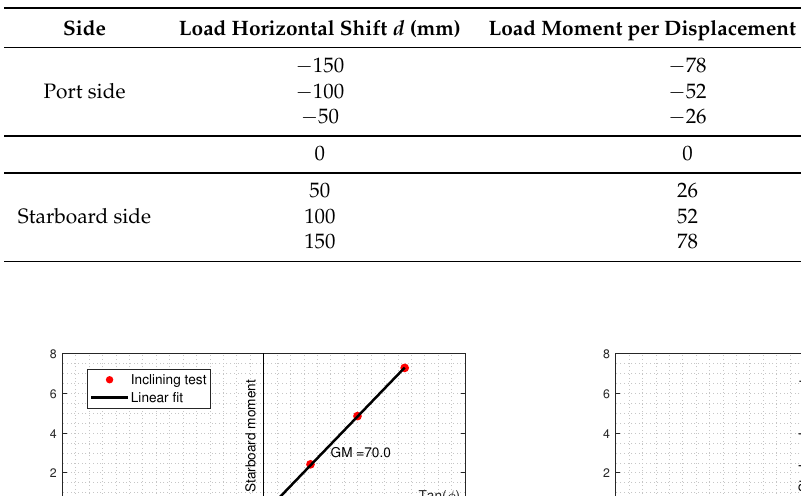
Figure 9. Model during Incline Test. Table 2. Inclination test.